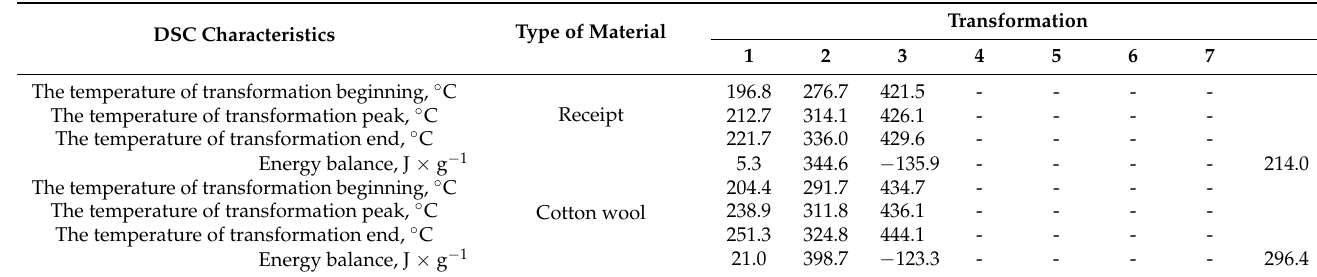
Table 3. Normalized transformation energy for successive transformations of tested paper waste and energy balance of the